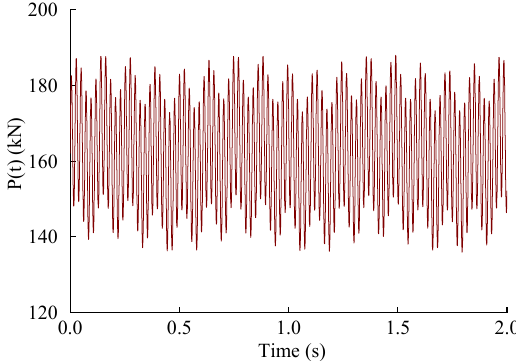
Figure 5. Time–history curve of train